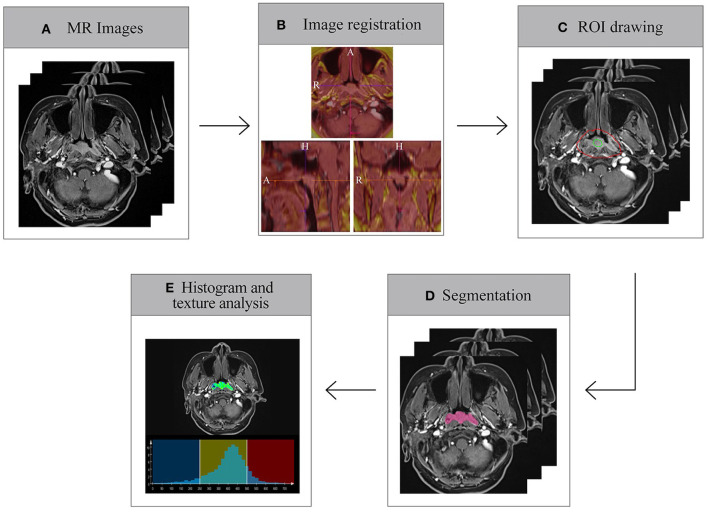
Schematic diagram of data processing.